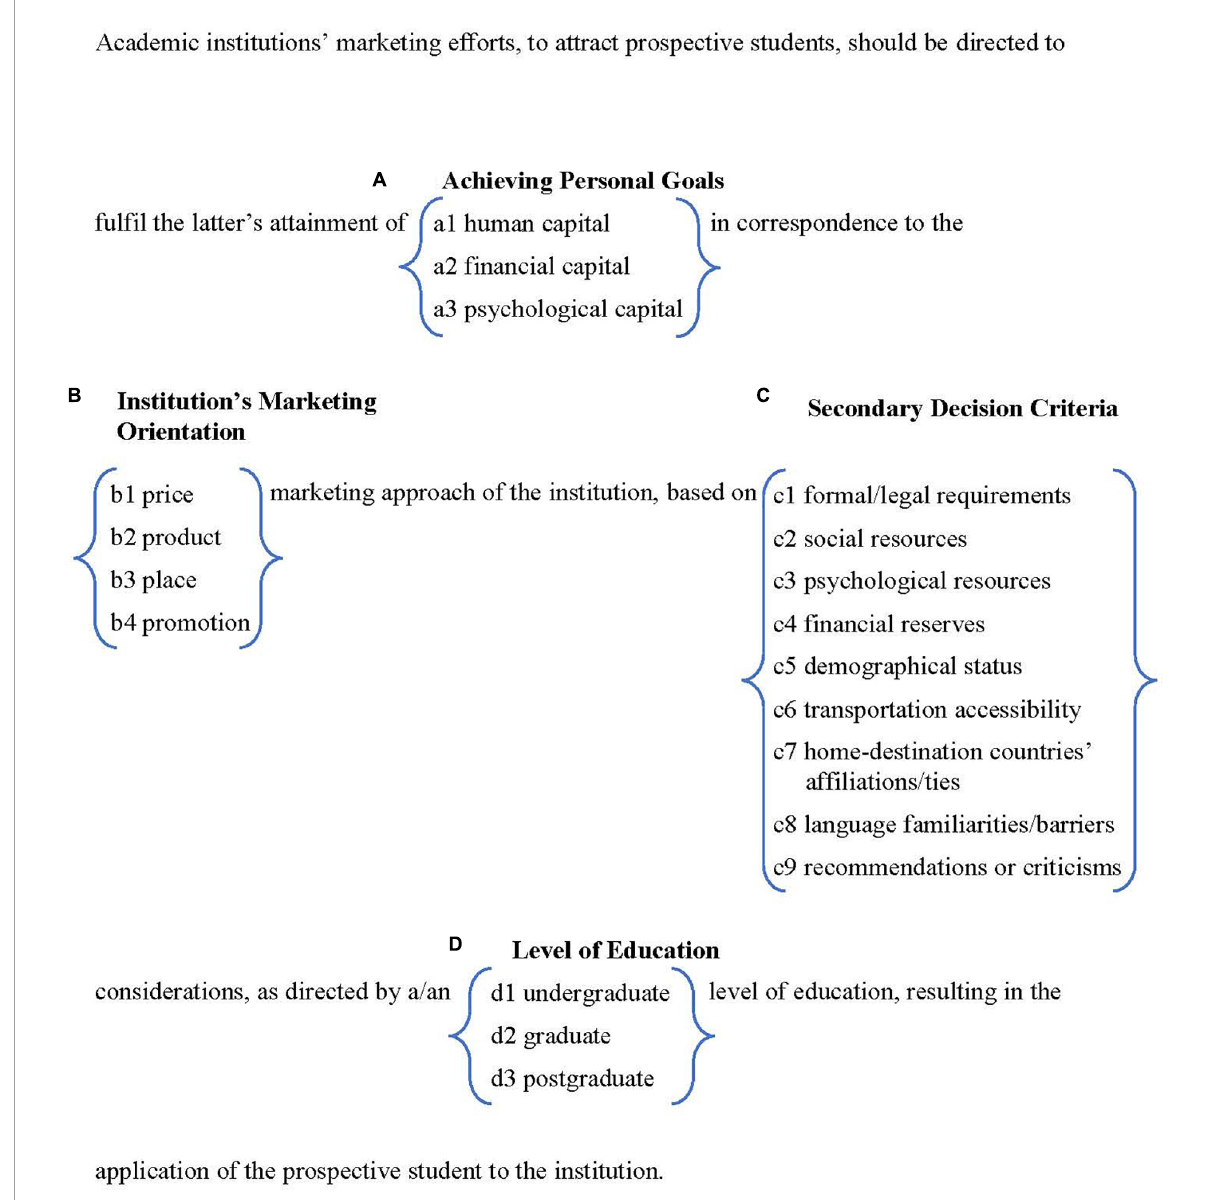
FIGURE1 Mapping sentence of marketing higher education to